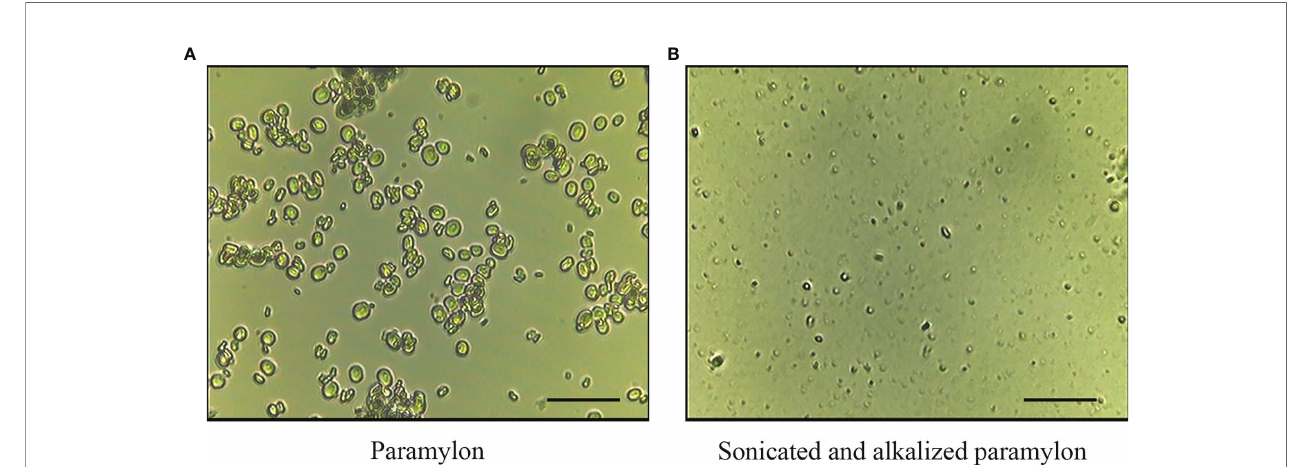
FIGURE 1 | Light microscopy observation of Pa and SA-Pa. Light microscopy (×400) observation of (A) untreated paramylon (Pa), and (B) ultrasonically treated alkalizated paramylon (SA-Pa) (scale bar = 5